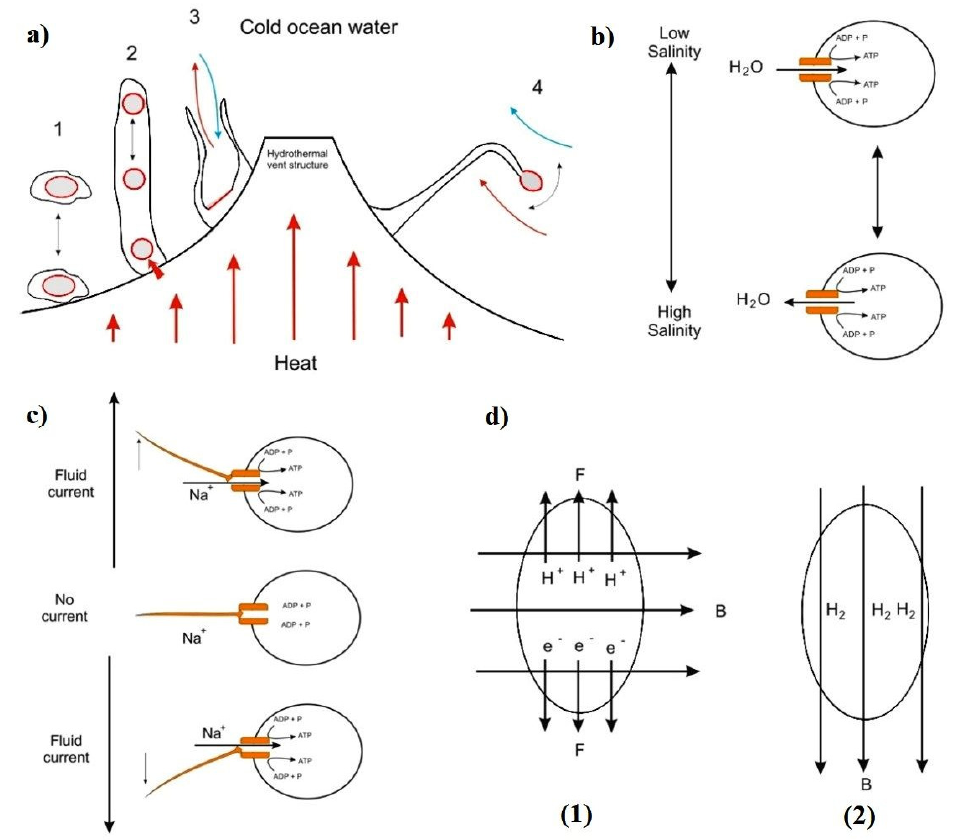
Figure 3. Hypothetical concept of organisms using other than light and chemical redox process to harvest energy: using change in cellular-molecular conformations by heat (a), using in-out flow of water by osmotic change (b), using kinetic-guided system in membrane to allow ion transfer (c), and using magnetic field (the field shown by B) and Lorentz force (shown by F; d). Details: (1a) mobile cellular thermotroph, (2a) sessile thermotroph with mobile vacuole to move in different heat gradient, (3a) sessile thermotroph with heat convection cavity, and (4a) sessile thermotroph with moveable body appendage to follow heat gradients Note: Red arrows – high temperature heat gradient, Blue arrows – low temperature heat gradient. Figure remade and inspired by Schulze-Makuch and Irwin (2002,